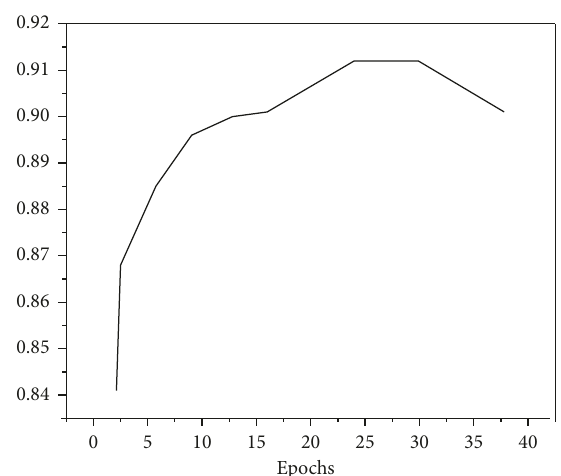
Figure 3: Convergence rate of HSI and RGB enhancement methods with/without